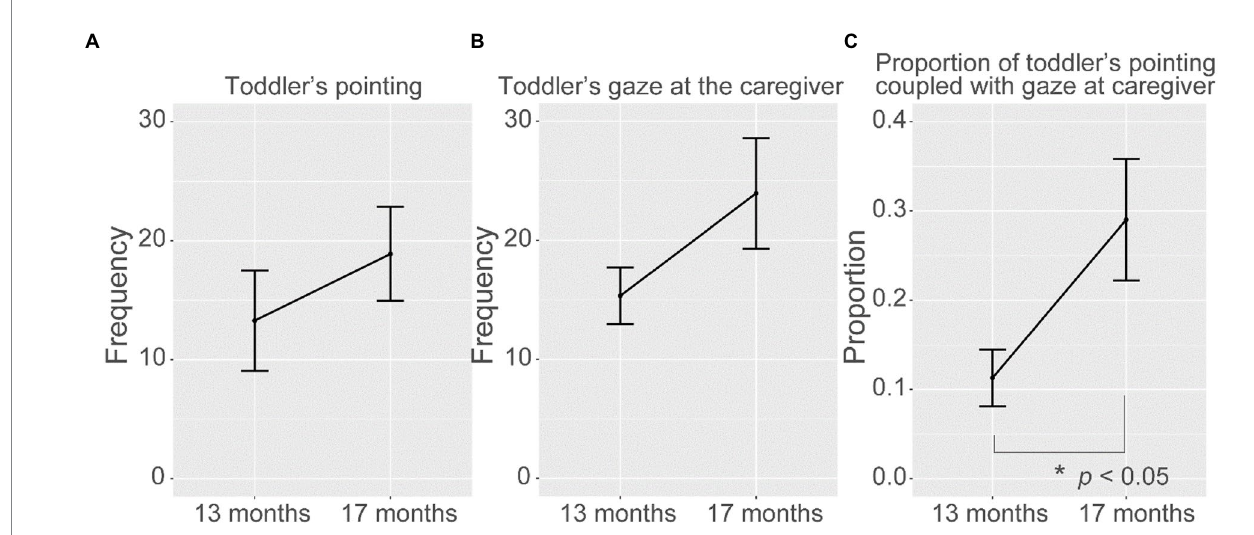
FIGURE 3 Differences in the frequency of (A) toddler’s pointing and (B) toddler’s gaze directed at the face of the caregiver between 13 and 17 months of age. (C) The proportion of pointing in which the infant looked at the caregiver during the time window of 2 s before and after the toddler pointed. The figure is based on the data from the three observations of lunchtime for six children at two time points (13 months and 17 months of age). Error bars represent the standard error of the